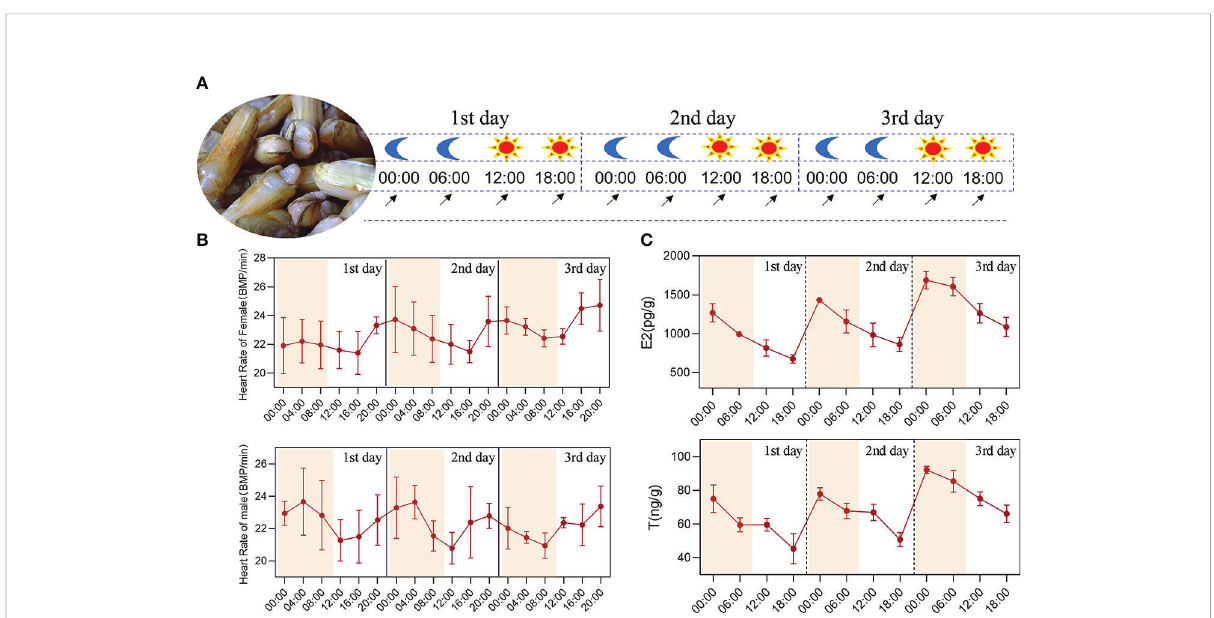
FIGURE 1 Circadian rhythm analysis of the physiological indicators in S . constricta . (A) The experimental design of circadian rhythm, the moon represents the nighttime point, the sun represents the daytime point, and the arrow represents the sampling time point. (B) The heart rate changes of female and male clams. (C) The circadian rhythm changes of estradiol and testosterone within 72 h in S. constricta (E2, estradiol; T, testosterone;